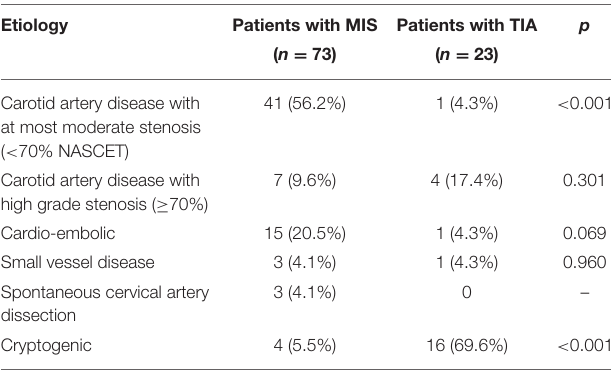
TABLE 2 | Etiologies of patients with minor ischemic stroke and transient ischemic